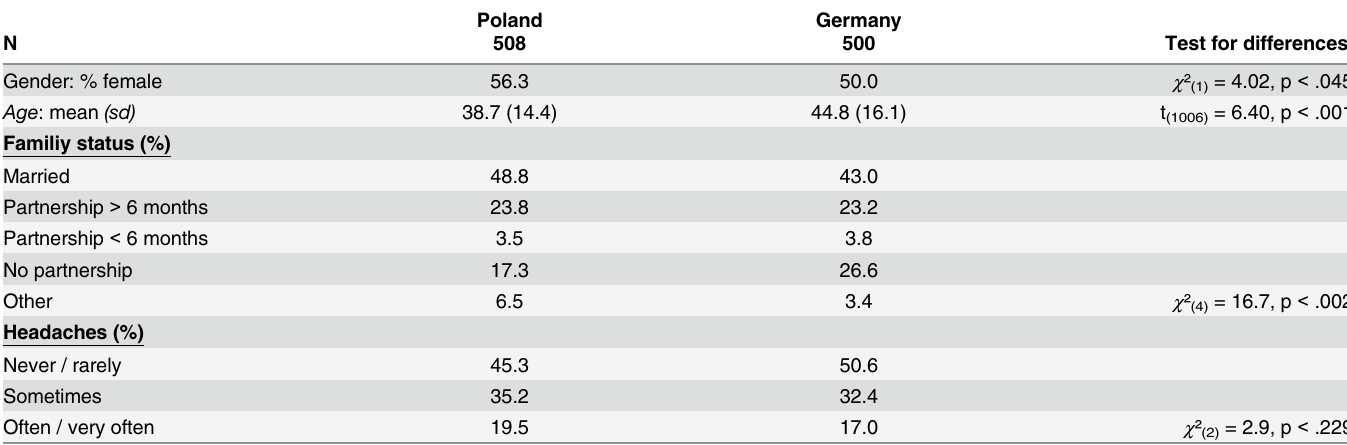
Table 1. Sample description.